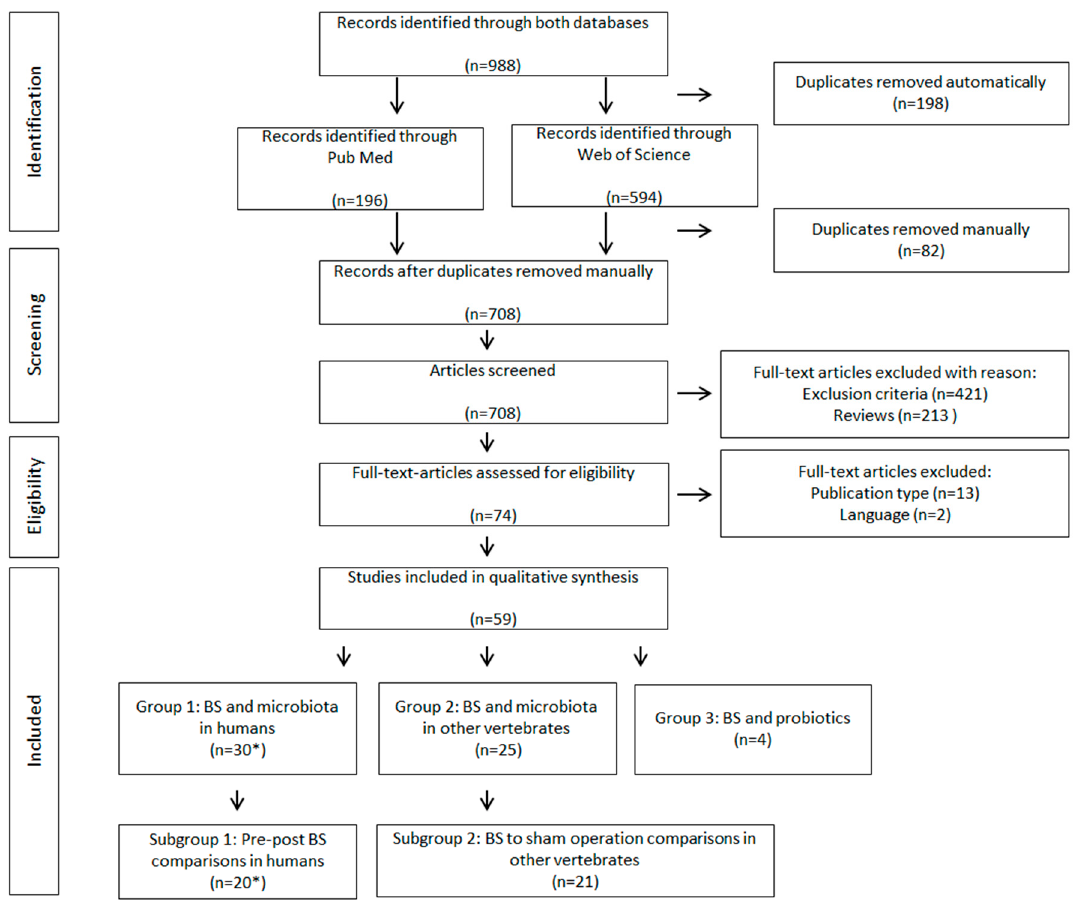
Figure 1. Flow chart of Preferred Reporting Items for Systematic Reviews and Meta-Analyses (PRISMA) systematic search. * 2 of the identified studies presented the same data and are discussed as a single study.